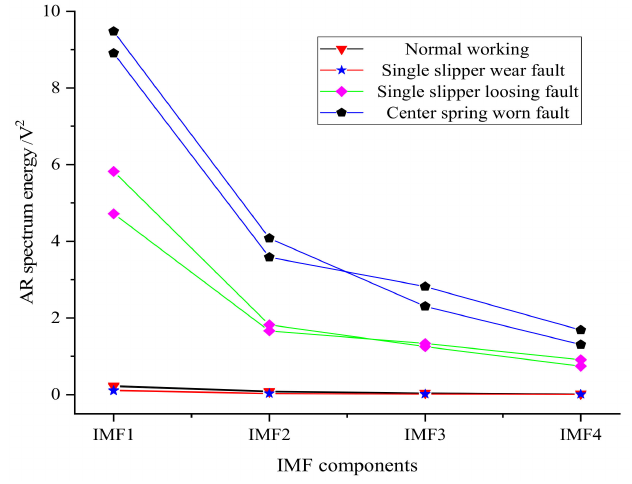
Figure 15. AR spectrum energy distribution of IMF components in different states.